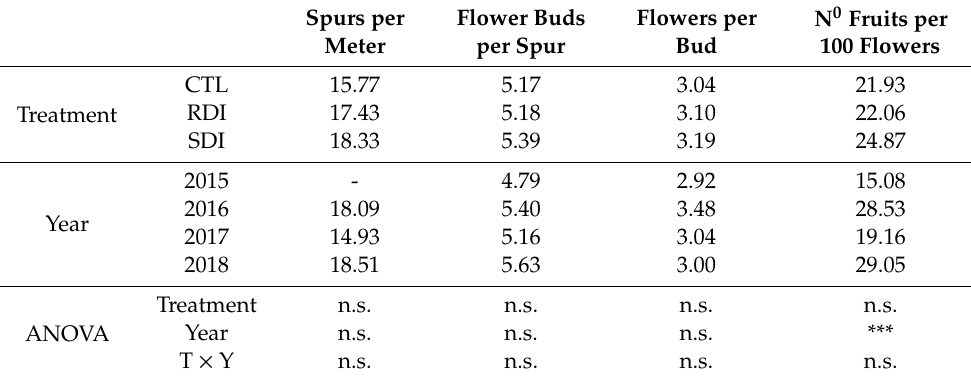
Spurs per Flower Buds Flowers per N 0 Fruits per Meter per Spur Bud 100 Flowers